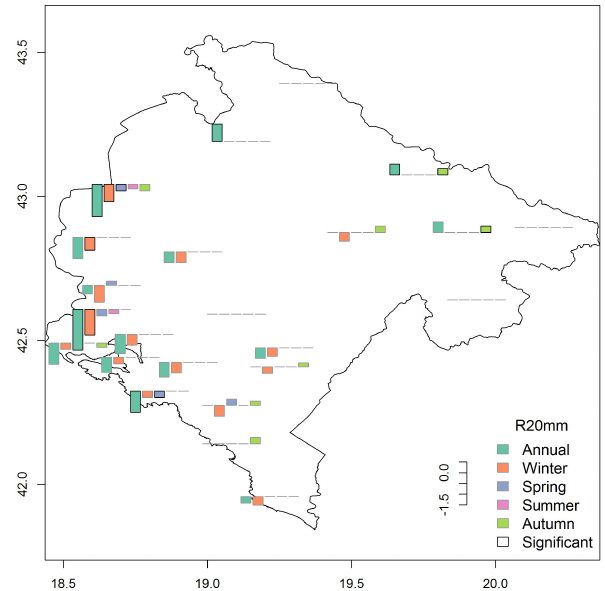
Figure 8. Decadal trends in the annual and seasonal precipitation fraction due to very wet days (R95TOT) in %dec − 1 .